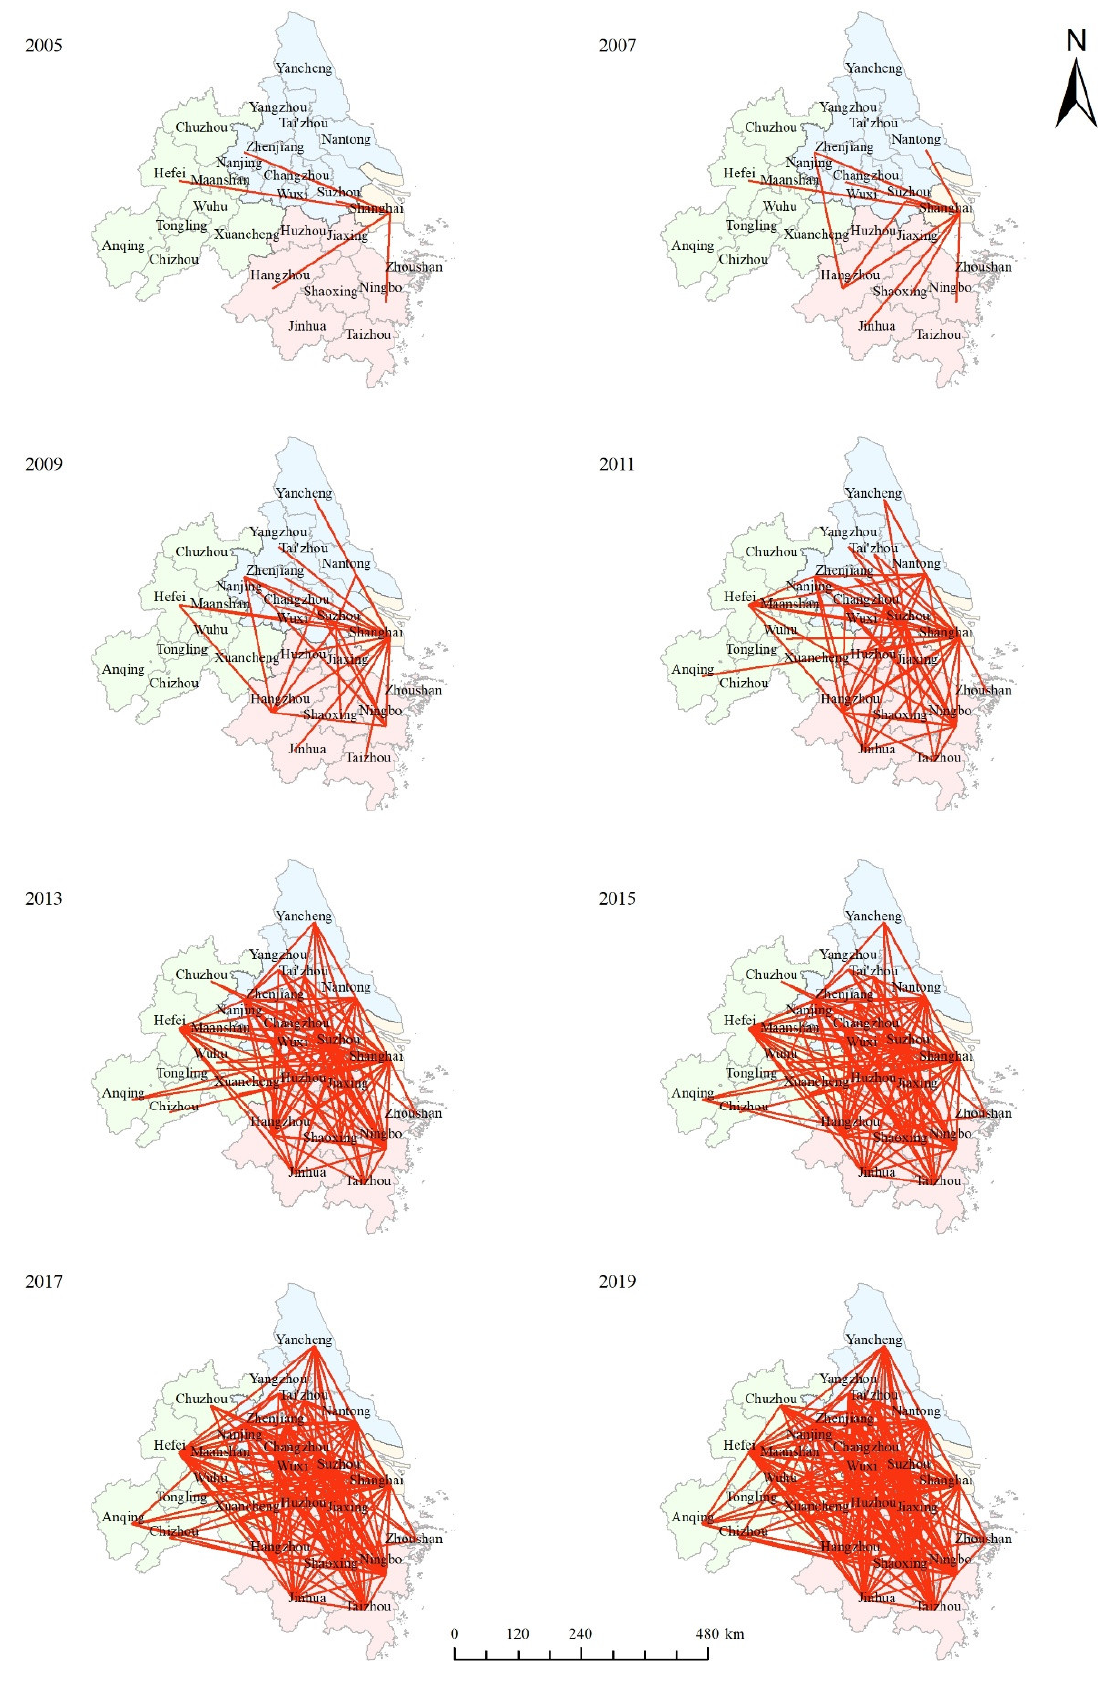
Figure 7. The dynamic linkage of cities in the YRDUA.